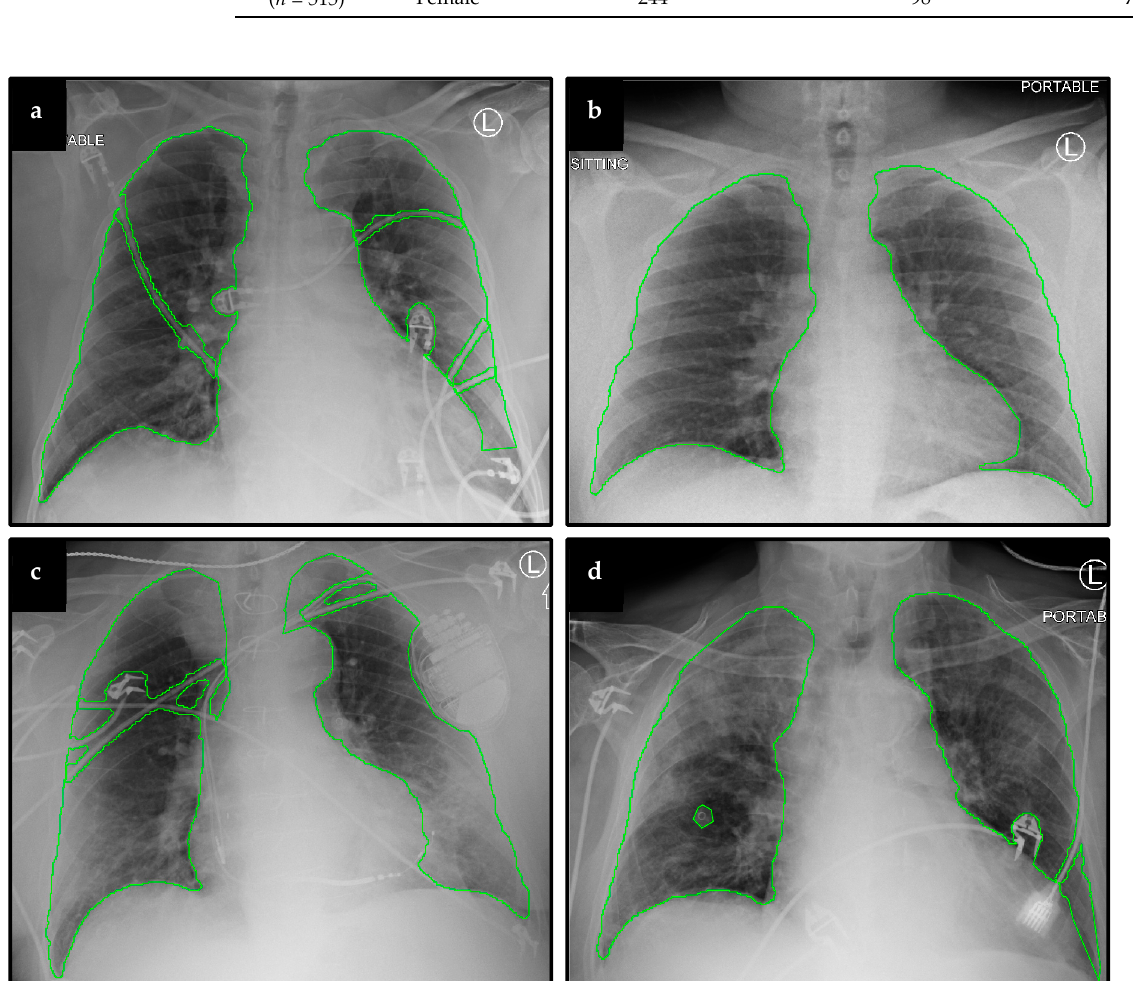
Figure 3. Representative CXRs and segmentation results. Displayed here are baseline CXRs taken from patients that later ( a ) required mechanical ventilation, ( b ) did not require ventilation, ( c ) survived the disease, and ( d ) did not survive.